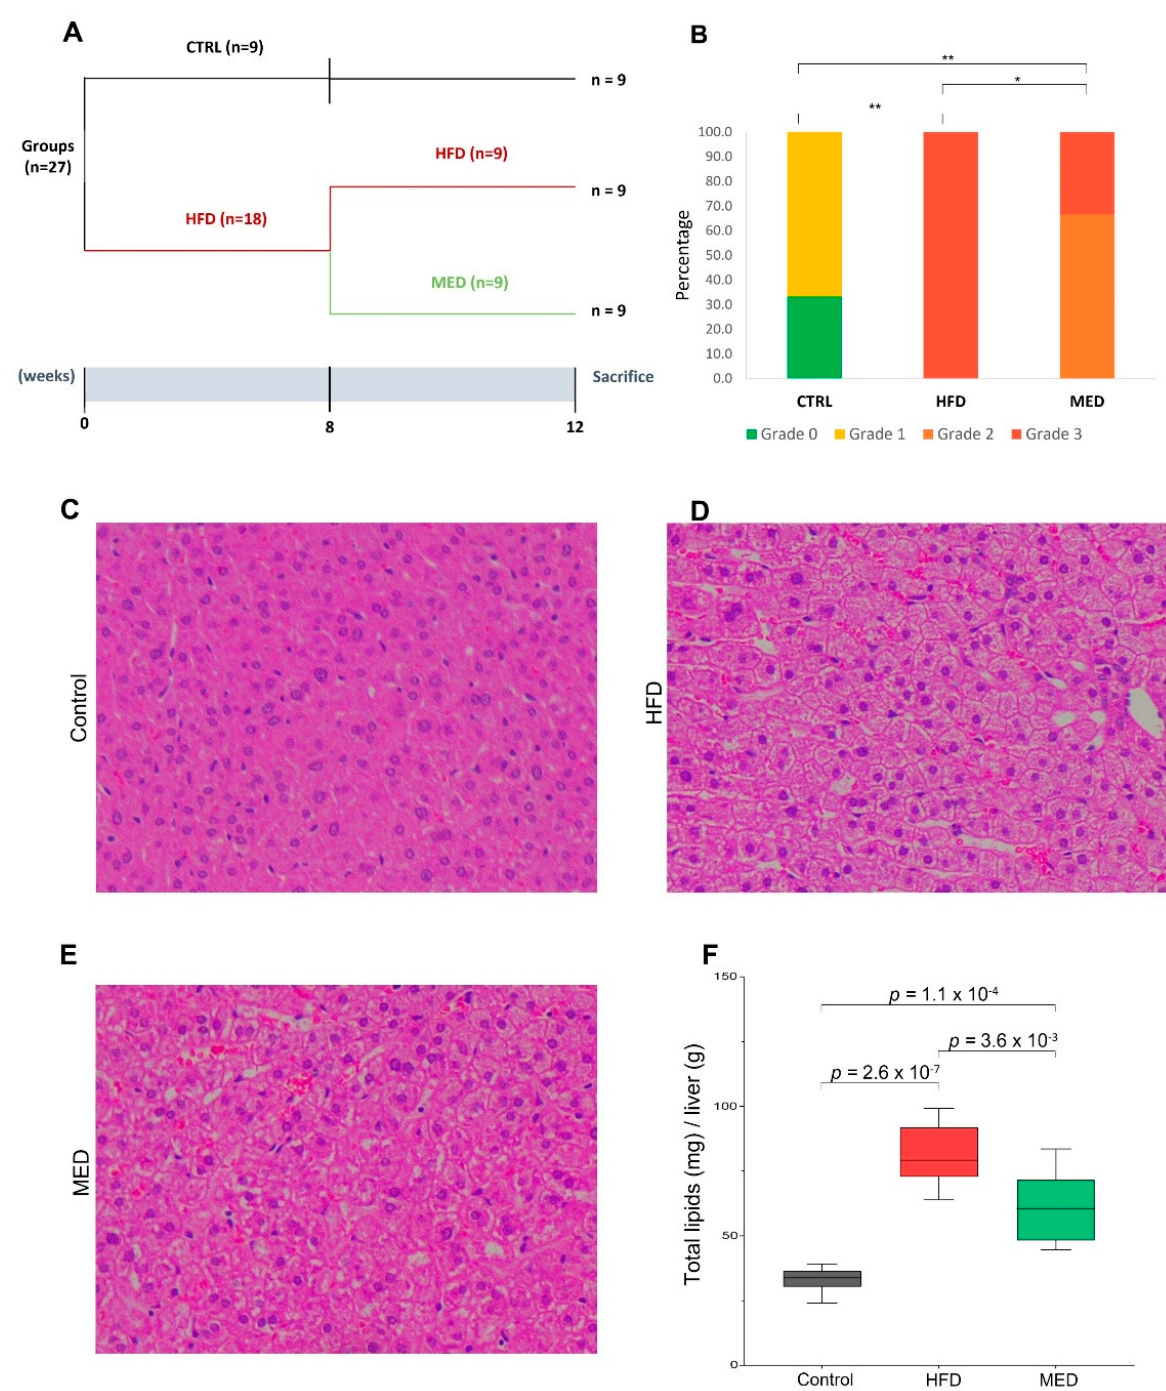
Figure 1. Effect of the HFD and MED on liver histology of Golden Syrian hamsters. ( A ) Outline of the experimental design. ( B ) Steatosis score of histological changes in the liver. Differences were detected using Fisher’s exact test (* p -value < 0.05, ** p -value < 0.001). ( C – E ) Histological analysis of steatosis in liver sections stained with Hematoxylin and Eosin (400 × ). ( F ) Relative hepatic lipid content of hamsters in experimental groups. CTRL, normal diet; HFD, high-fat diet; MED, Mediterranean-like diet. Differences among groups in hepatic total lipid content were detected by Student t -test. All results were considered statistically significant at p -value < 0.05.